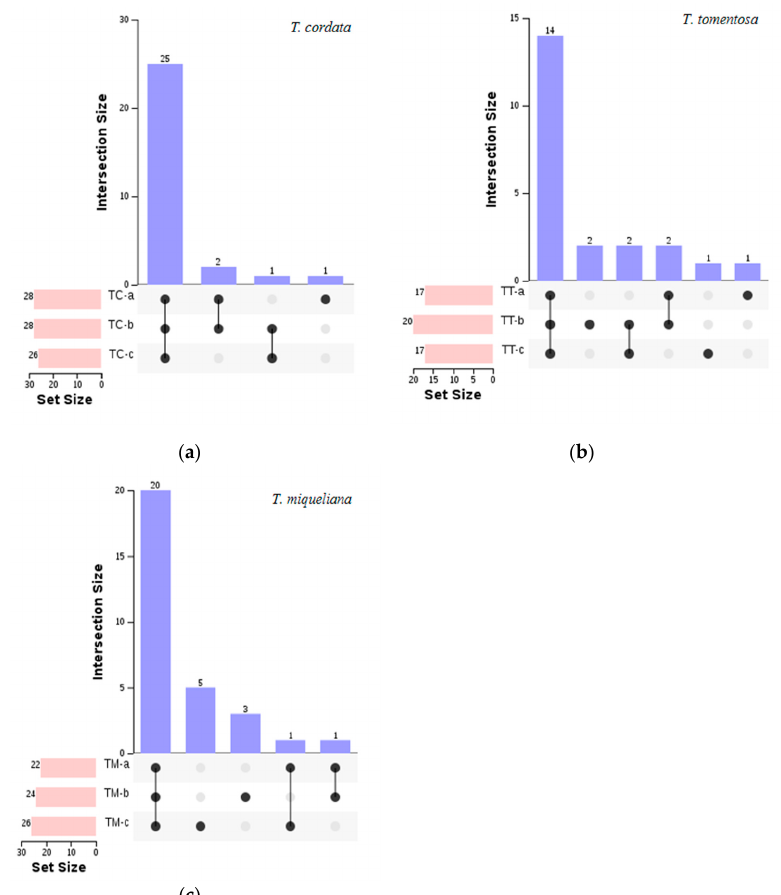
Figure 2. UpSet diagrams based on the aroma components at different flowering stages of the three species. (a) T. cordata ; (b) T. tomentosa ; (c) T. miqueliana. Note: "set size" represents the dataset of aroma components in each species of Tilia at different flowering periods; the horizontal bar chart on the left represents the statistical value of floral fragrance components in each period; the single point of the intermediate matrix represents the existence of unique aroma components in a certain period, and 2 or 3 points are connected by lines to represent the unique components with intersection of multiple periods; the numbers at the top of the vertical bars represent the values of the unique aroma components at the intersection points at different periods.